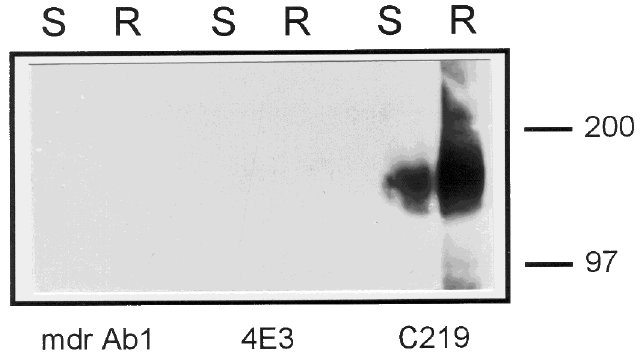
Fig. 2. Purified membrane fractions isolated from CHO-K1 (S: vinblastine sensitive) and CHOVBR (R: vinblastine resistant) cells were analyzed by Western blotting. The immunoblot was incubated with the anti-P-gp mdr Ab-1, 4E3, and C219 antibodies. Note that specific antigen-antibody complexes were only visualized when C219 MAb was used.